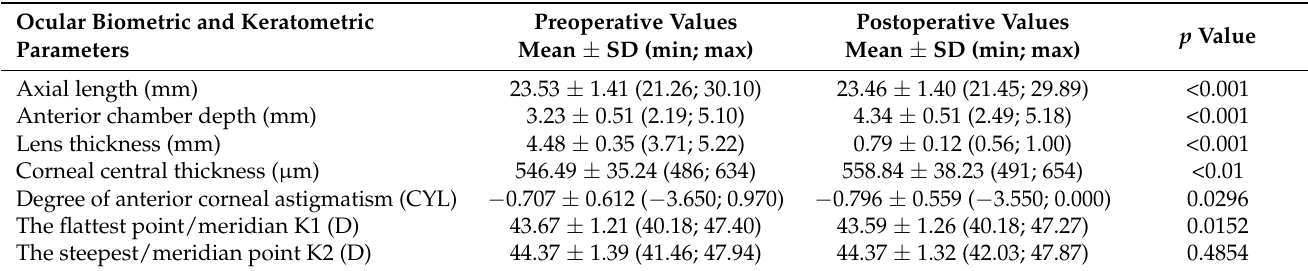
Table 2. Pre-/postoperative centrality and dispersion indicators of the ocular biometric and kerato- metric parameters.